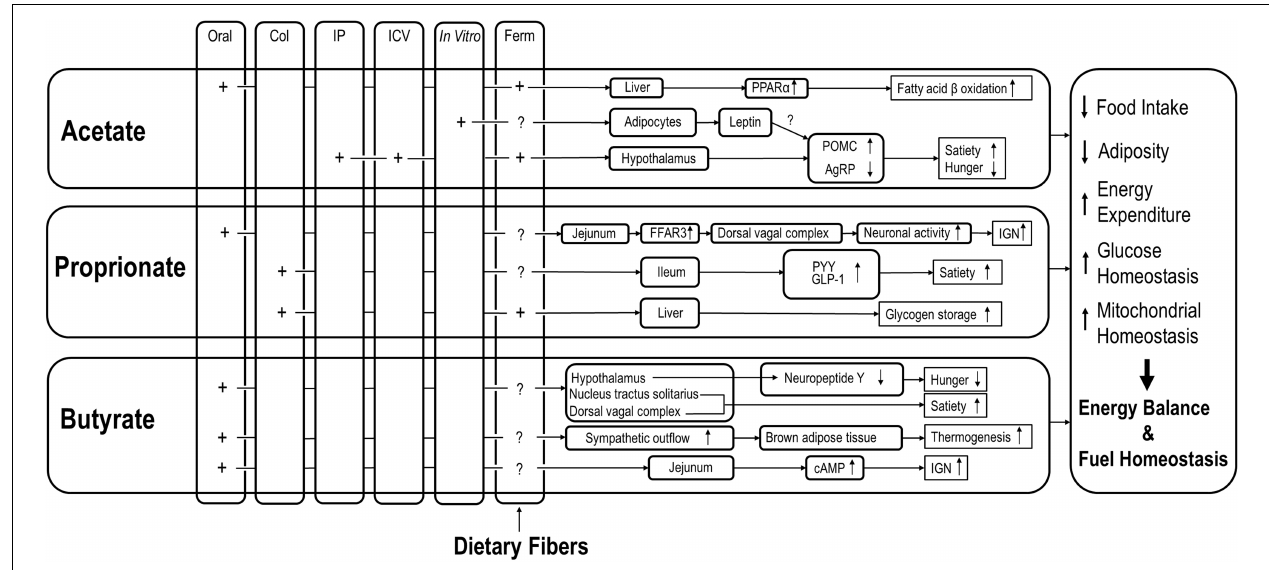
FIGURE 1 | Effects of SCFAs via different routes of administration on various aspects of energy balance regulation and fuel homeostasis. COL, colonic; IP, intraperitoneal; ICV, intracerebroventricular; IGN, intestinal gluconeogenesis; Ferm, fermentation; A column of Ferm is added to point out the possibility that SCFA originating from dietary fibers may all have these effects as well, but those studies mostly lack the site-specific efficacy; Note that the figure did not summarize all the findings that were included in this manuscript since some contradictory findings may need further